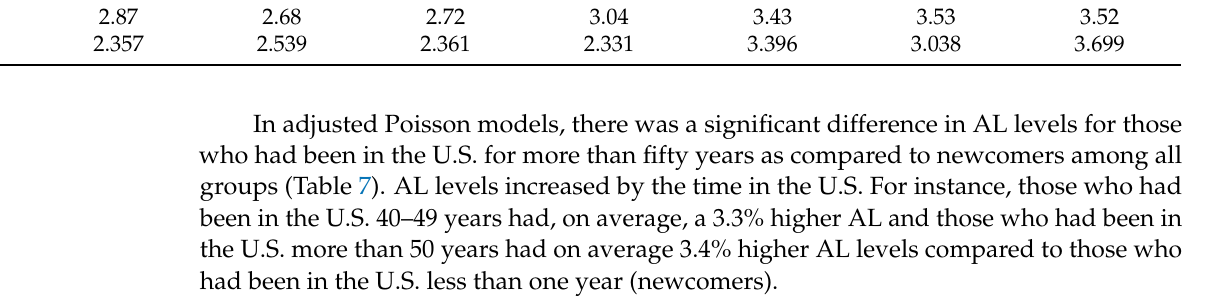
Table 7. Exp( β ) (95% CI) for the adjusted association of length of time in the U.S. with AL. Length of Time in